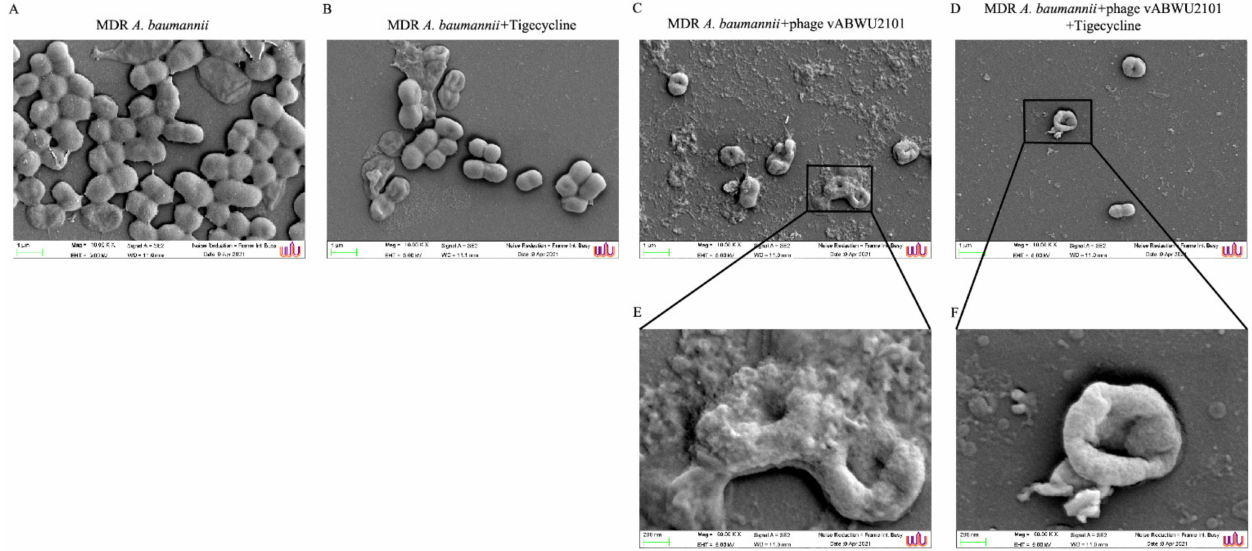
Figure 10. Ultrastructural analysis of A. baumannii treatment observed by FE-SEM at magnifications of × 10,000 and × 50,000. ( A ) MDR A. baumannii. ( B ) MDR A. baumannii treated with tigecycline at 1/32 × MIC. ( C , E ) MDR A. baumannii treated with phage vABWU2101 at an MOI of 1. ( D , F ) MDR A. baumannii treated a combination of phage vABWU2101 at an MOI of 1 and tigecycline at 1/32 ×